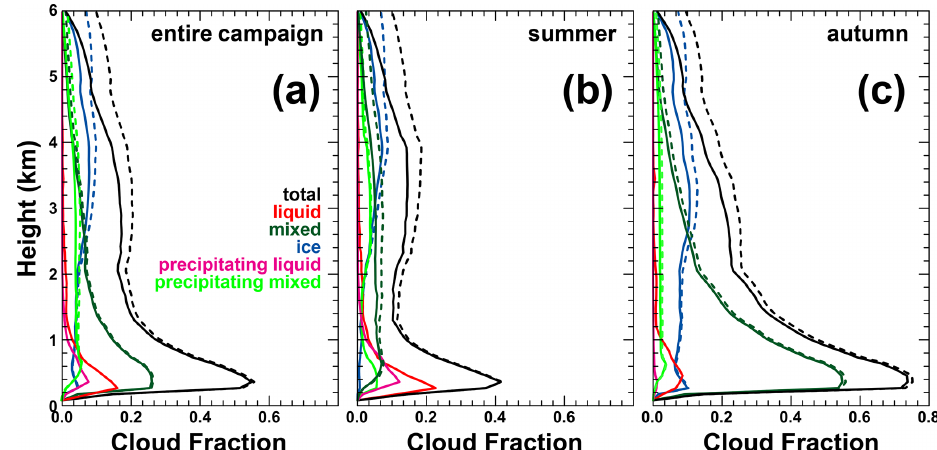
Figure 5. Profiles of cloud fraction for different cloud types as obtained using Cloudnet for the entire ACSE campaign (a) , summer (b) , and autumn (c) . All solid profiles refer to clouds for which the cloud-top height was located below 6km height. The dashed lines refer to the total cloud fraction with respect to all clouds, i.e. including those with undetected cloud-top